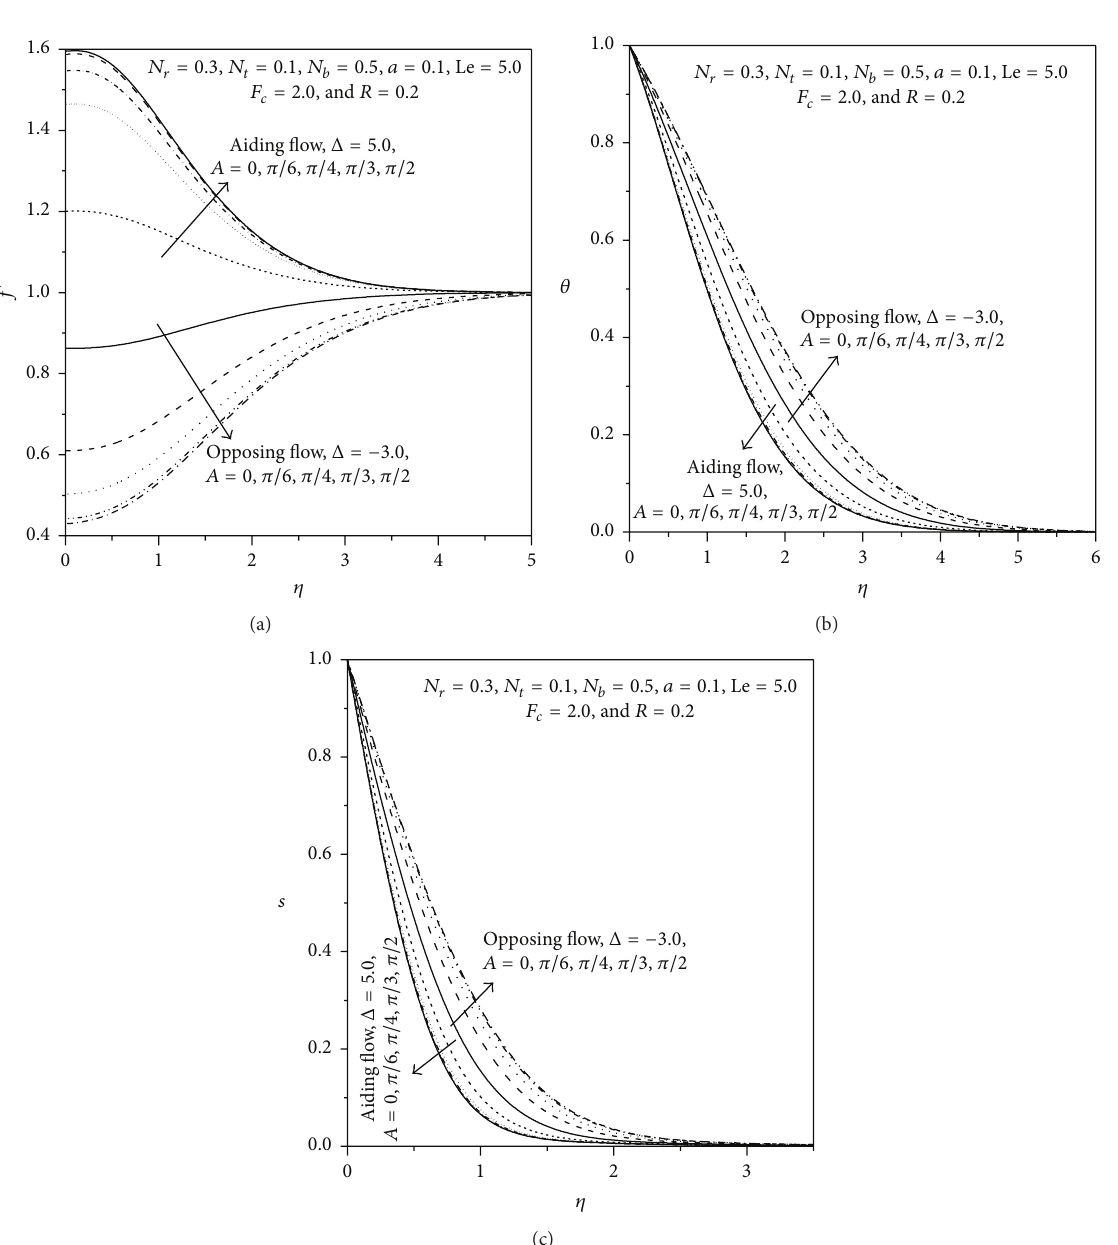
flow. When the surface is vertical, the smallest temperature and nanoparticle volume fraction distributions are observed for aiding flow whereas largest temperature and nanoparticle volume fraction distributions are observed for opposing